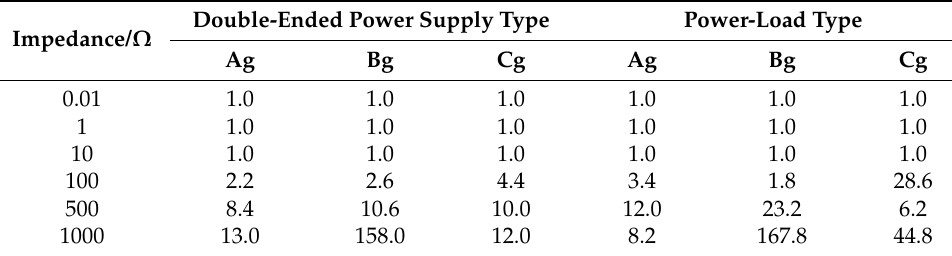
Table 1. High-impedance ground fault simulation result (ms). Impedance/